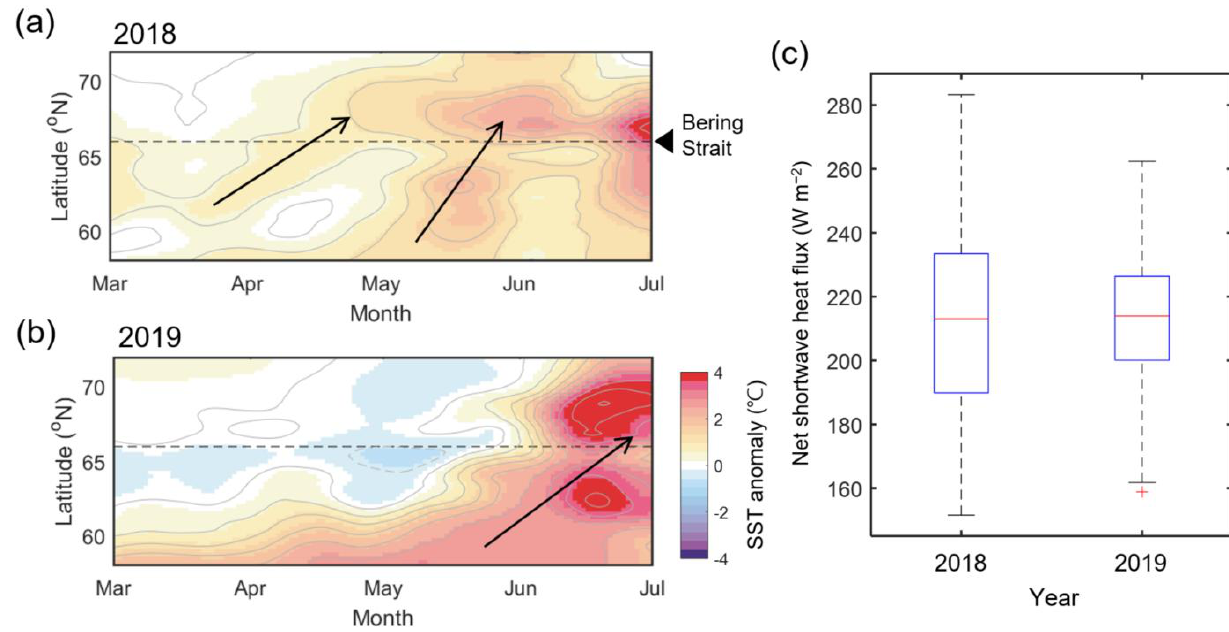
Figure 9. Hovmöller diagrams showing 15-day low-passed zonal mean SST anomaly during March–July in ( a ) 2018 and ( b ) 2019, averaged in the zonal direction between 160–170 ◦ W. ( c ) Box plots of net shortwave heat flux in both years during June, with the highest seasonal heat flux. The red line in each box plot refers to the mean value for each year, and the red cross represents the outlier.